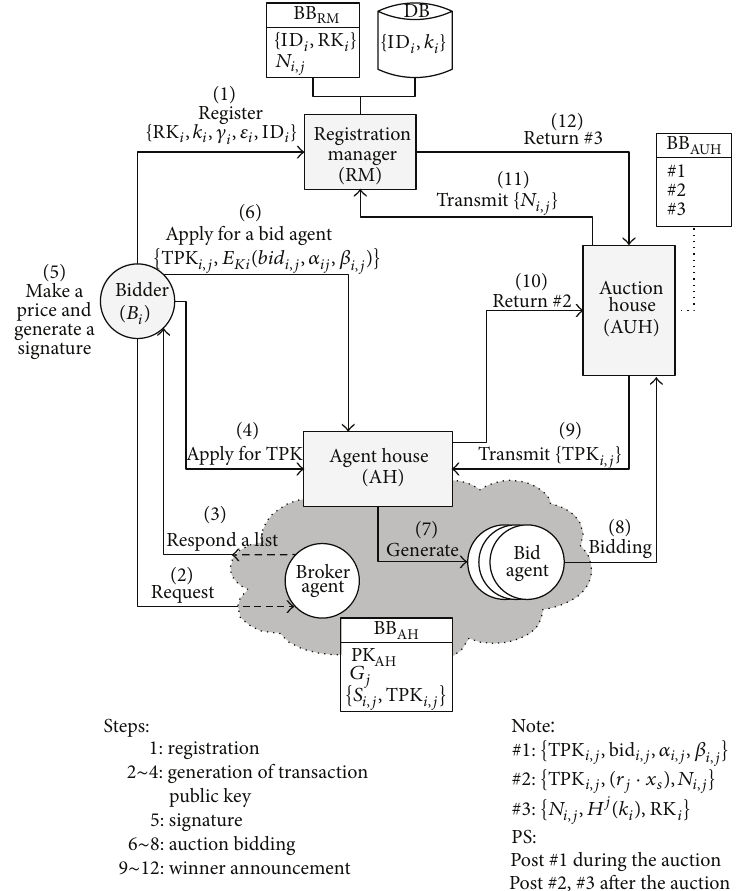
Figure 5: Flow chart of proposed